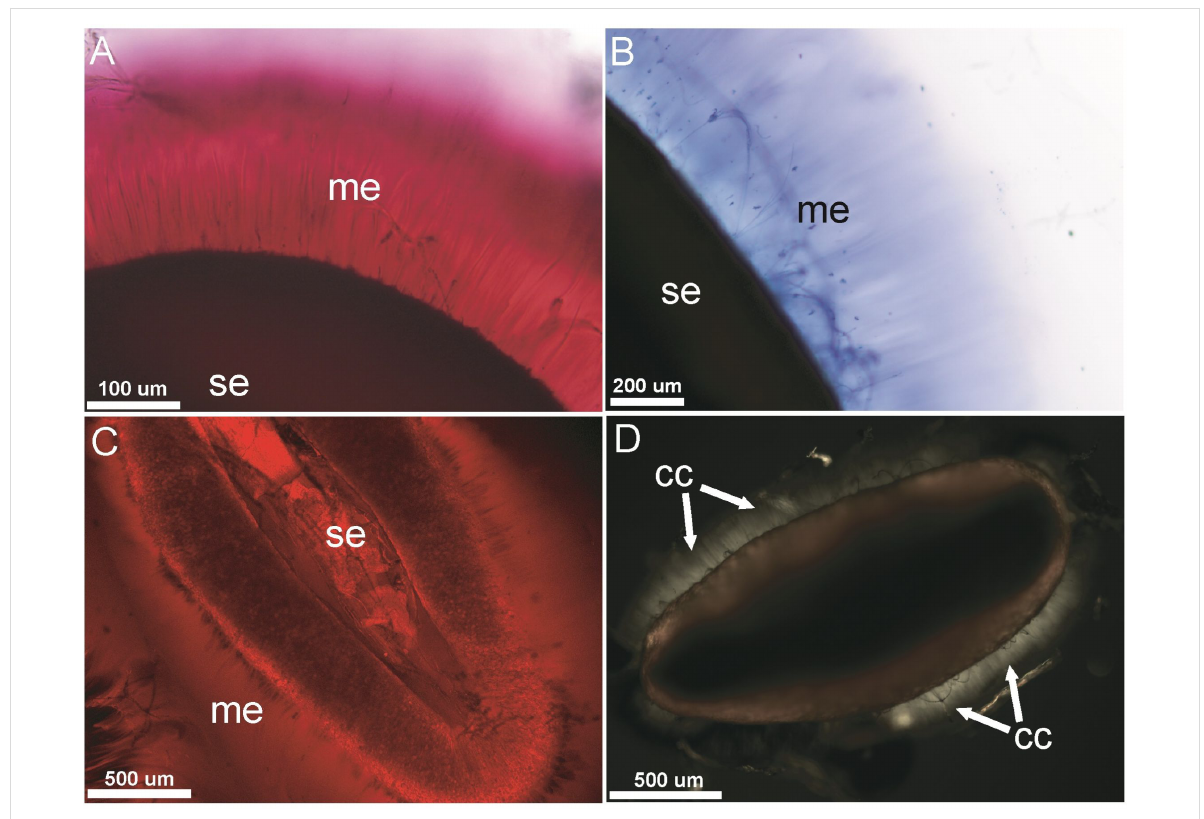
Figure 1: Mucilage composition. Bright field and fluorescence microscopy images of different staining reactions: A – pectin staining with ruthenium red; B – cellulose staining with methylene blue; C – cellulose staining with Direct Red 23, fluorescence image; D – detection of crystalline cellulose in polarized light. Characteristic signal of the cellulose fibrils (arrows); Cellulose fibrils are imbedded in the mass of pectins (cc – crystalline cellulose, me - mucilage envelope, se -